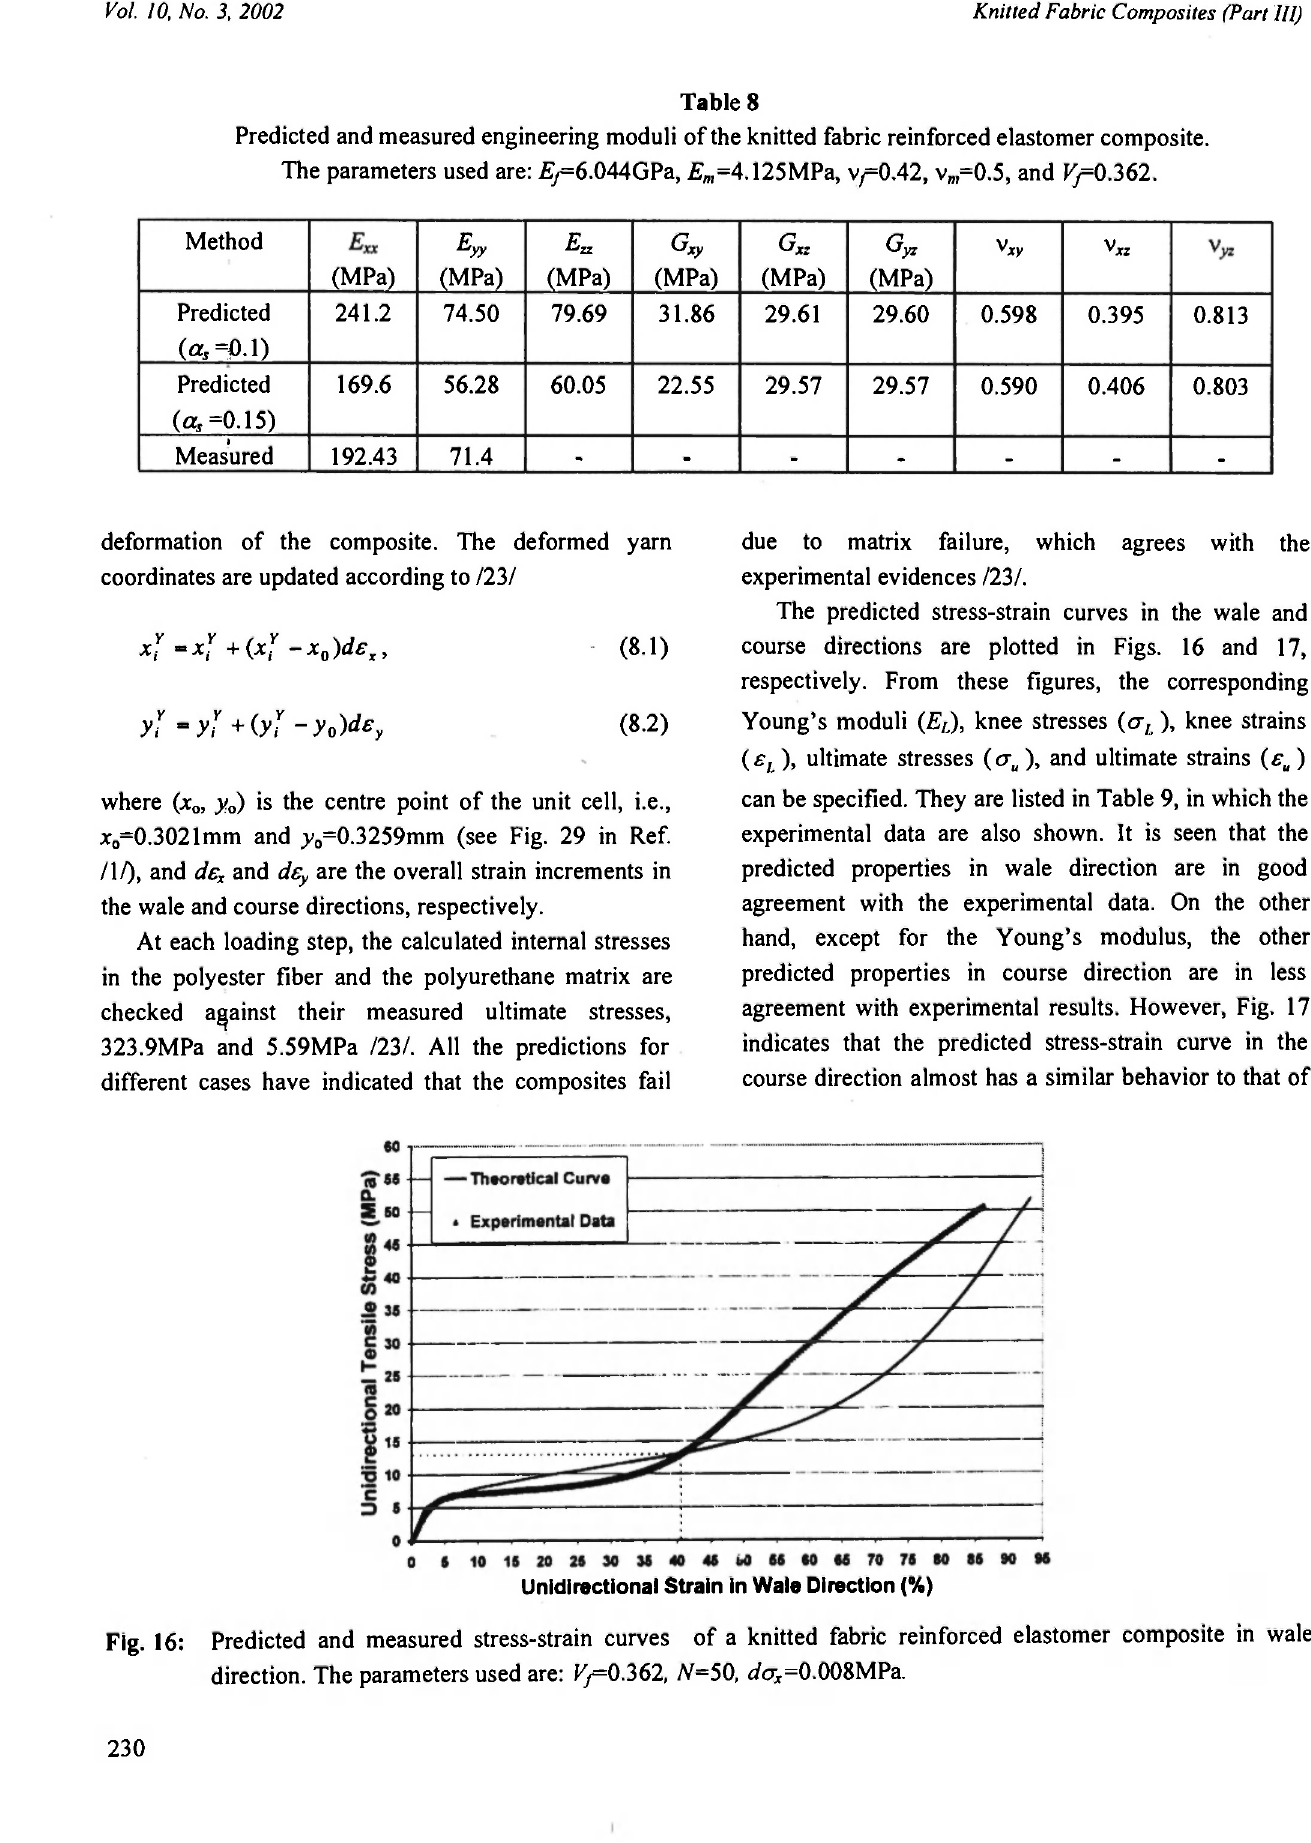
Predicted and measured engineering moduli of the knitted fabric reinforced elastomer composite. The parameters used are: £ ; =6.044GPa, £„,=4.125MPa, v^O.42, v m =0.5, and Vj= 0.362.